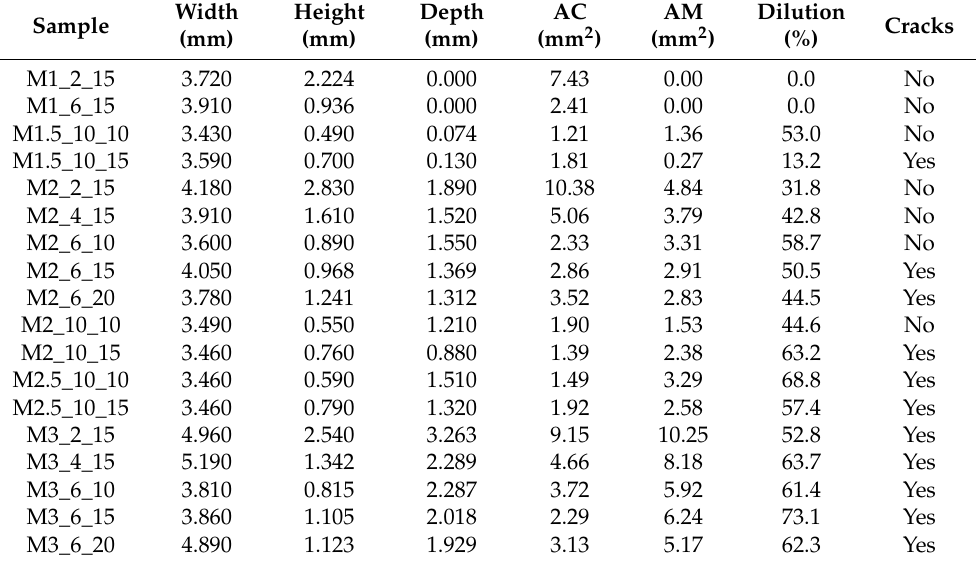
Table 4. Dimensional analysis and dilution of clads produced by DLD with PHT (300 ◦ C). AC—Clad Area; AM—Melting